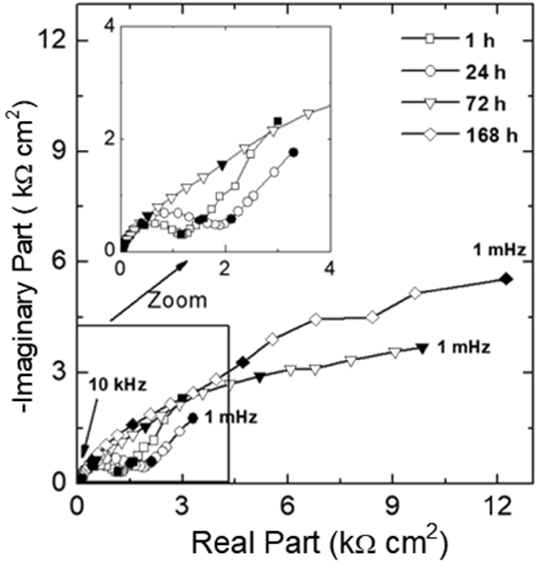
Figure 10. Nyquist diagrams of a B (as-cast) sample at different times of immersion in 3.5 wt.% NaCl solution.